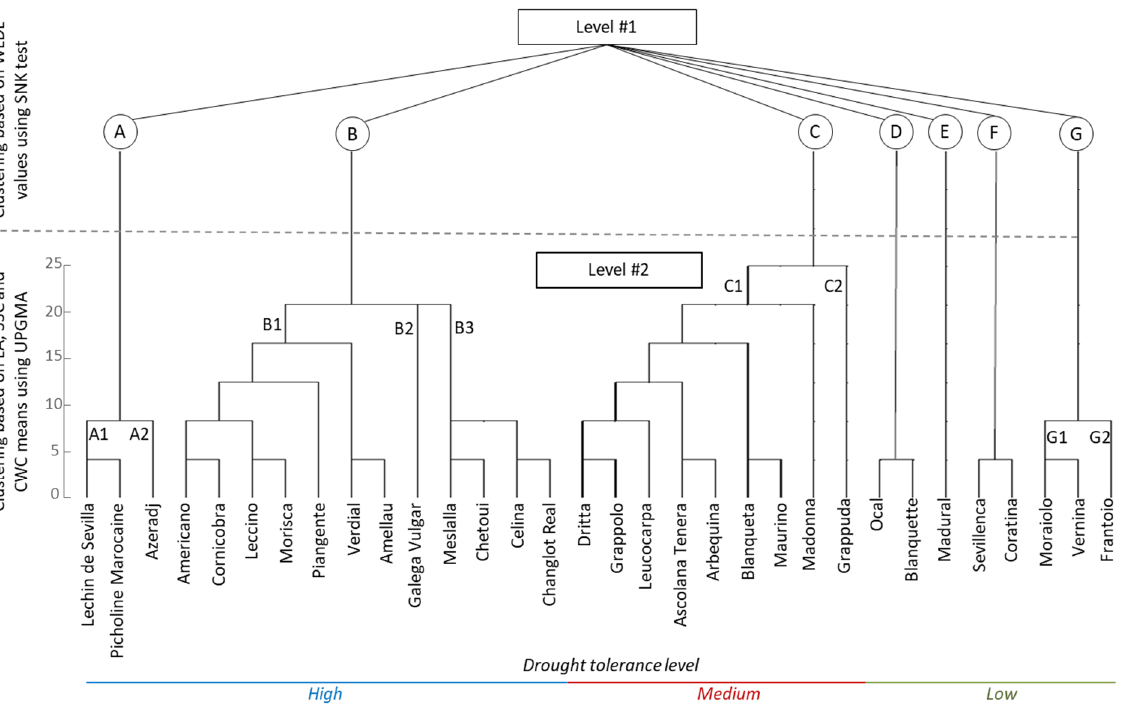
Figure 2. Two-level clustering of the 32 olive varieties studied in the first experiment for drought tolerance based on phenotypic markers identified by correlation test: WLDL (level 1), LA, SSC and CWC (level 2).